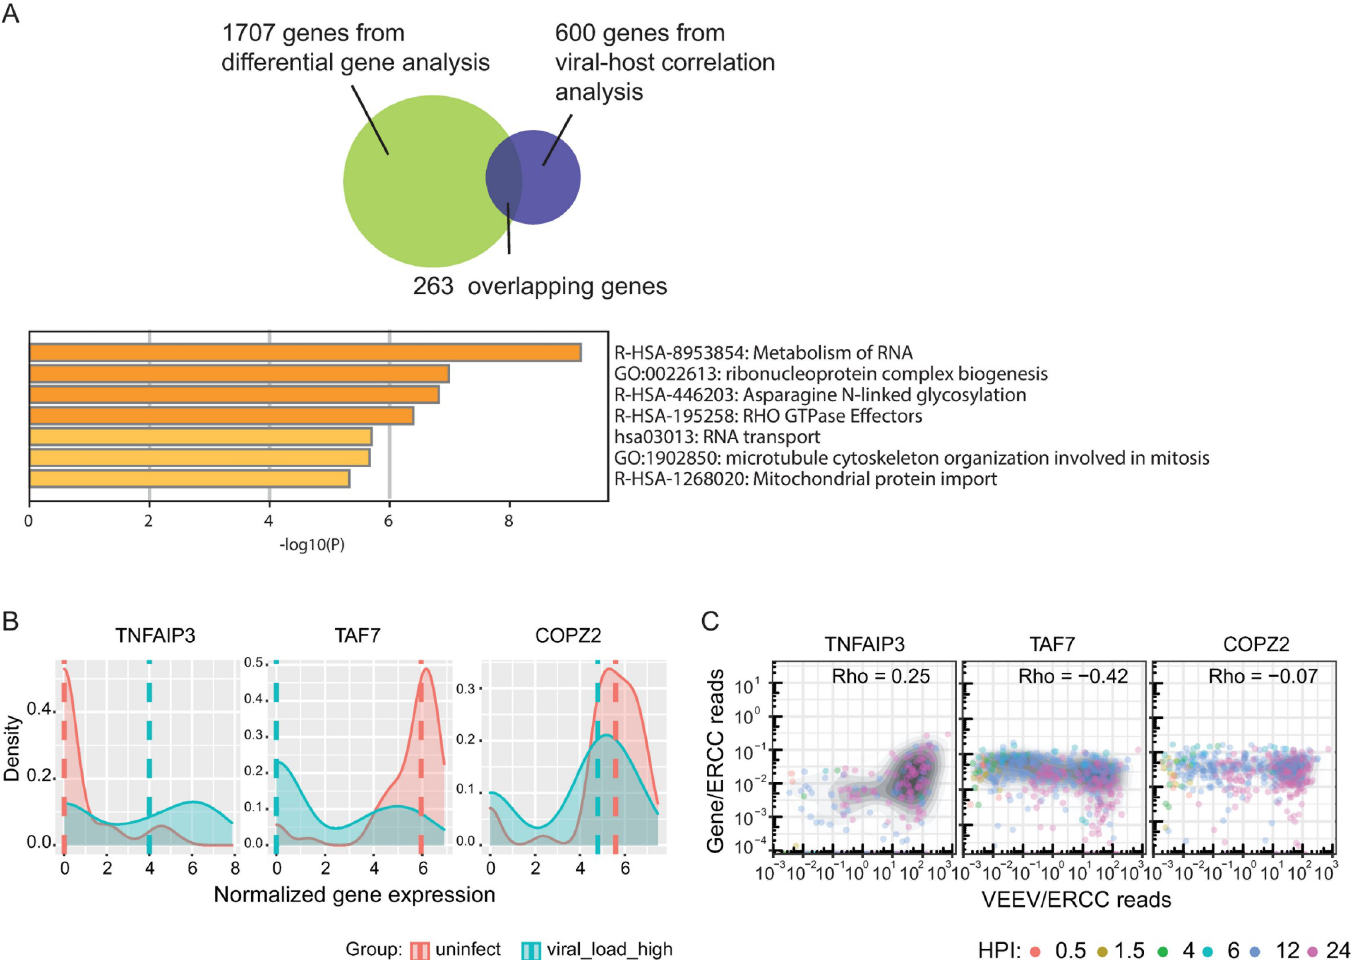
Fig 2. Host genes and pathways are altered during VEEV infection. (A) A Venn diagram showing the number of unique and overlapping genes that emerged from the differentially gene expression analysis and host RNV/vRNA correlation analysis. Molecular function terms and P values derived from Gene Ontology (GO) enrichment analysis of 263 genes that are both differentially expressed between high vRNA and uninfected cells and correlated with vRNA. (B) Ridge plots of representative host genes that are differentially expressed between high vRNA and uninfected cells and a gene (COPZ2) whose level is unaltered. 50 cells from each group were selected for plotting. Dash lines indicate median expression level of the corresponding genes. Gene expression was normalized using the following formula: ln ((gene counts / ERCC counts) + 1). (C) Representative scatter plots of host gene expression versus vRNA abundance and corresponding Rho Spearman’s correlation coefficients. Each dot is a single cell colored by the time postinfection, and the shaded contours indicate cell density (greyscale, darker is higher). HPI, hours postinfection; MOI, multiplicity of infection; ERCC, External RNA Controls Consortium; TNFAIP3, Tumor Necrosis Factor Alpha-Induced Protein 3; TAF7, TATA-Box Binding Protein Associated Factor 7; COPZ2, COPI Coat Complex Subunit Zeta